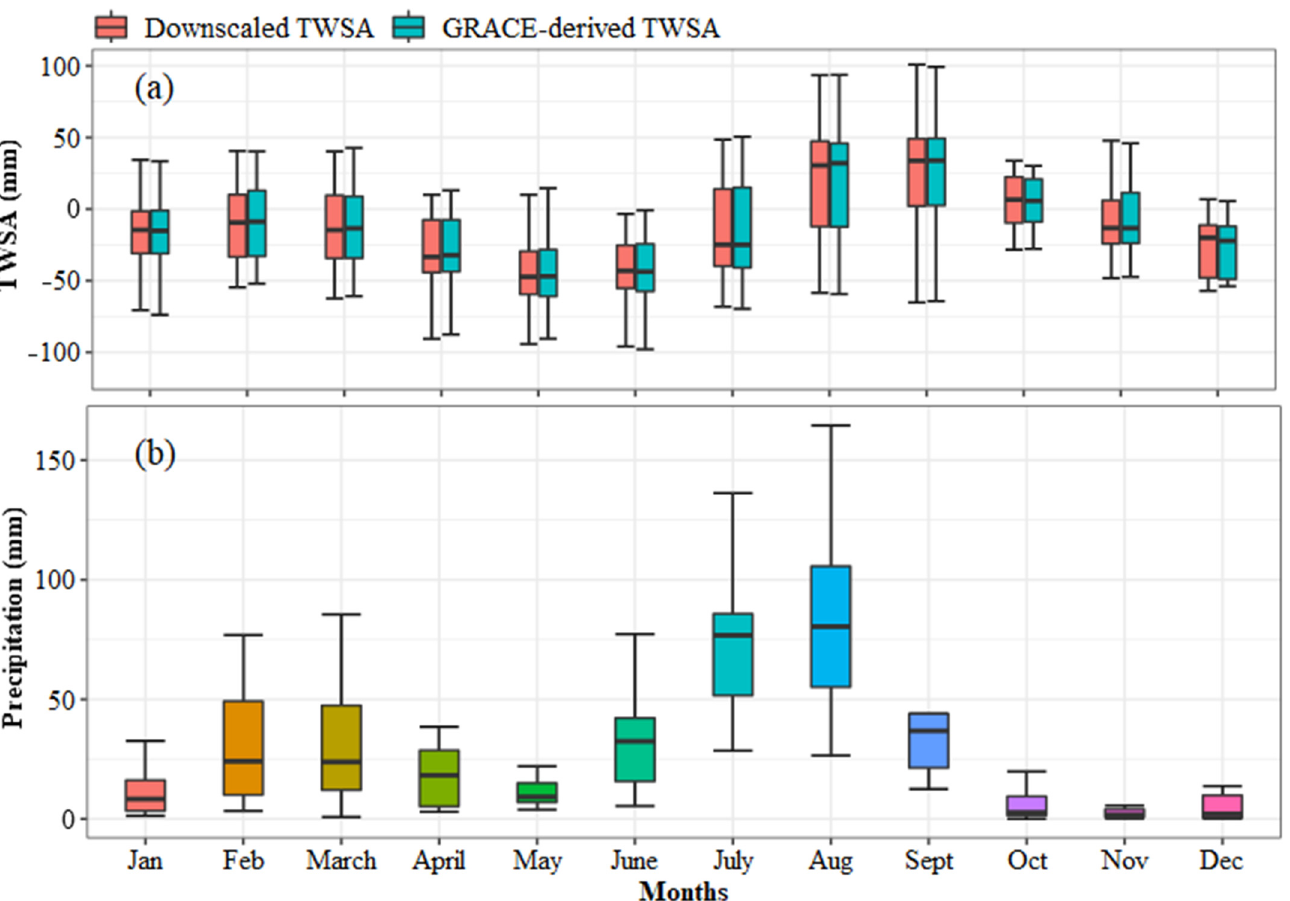
Figure 8. Box plots showing ( a ) the monthly distribution of GRACE and downscaled TWSA and ( b ) precipitation in the IBIS from 2003 to 2016.